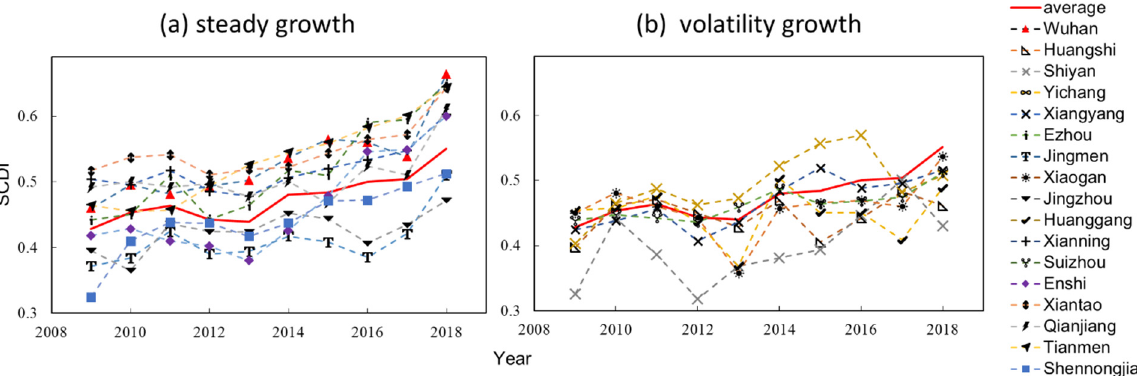
Figure 5. Trend of SCDI in Hubei Province during 2009–2018: ( a ) the steady growth of SCDI; ( b ) the volatility growth of SCDI.